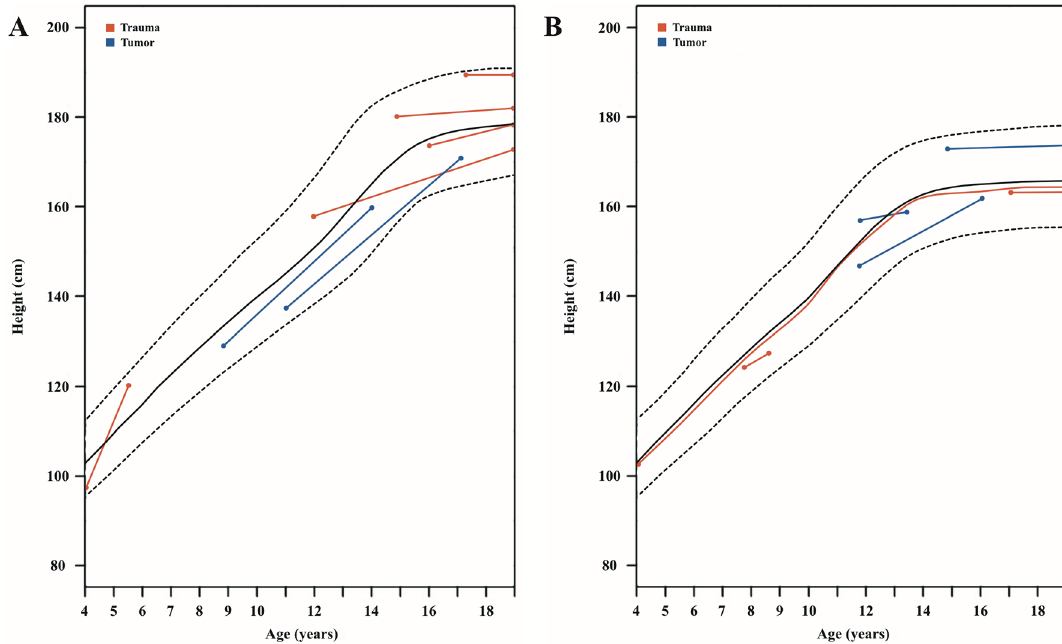
Figure 3. Patients’ height progress during follow-up, according to the new austrian height and proportion percentile curve 34 . ( A ) Percentile progress of male patients’ height (red: trauma patients, blue: tumor patients). ( B ) Percentile progress of female patients’ height (red: trauma patients, blue: tumor patients). *Patient number 1 is included from 4 to 19